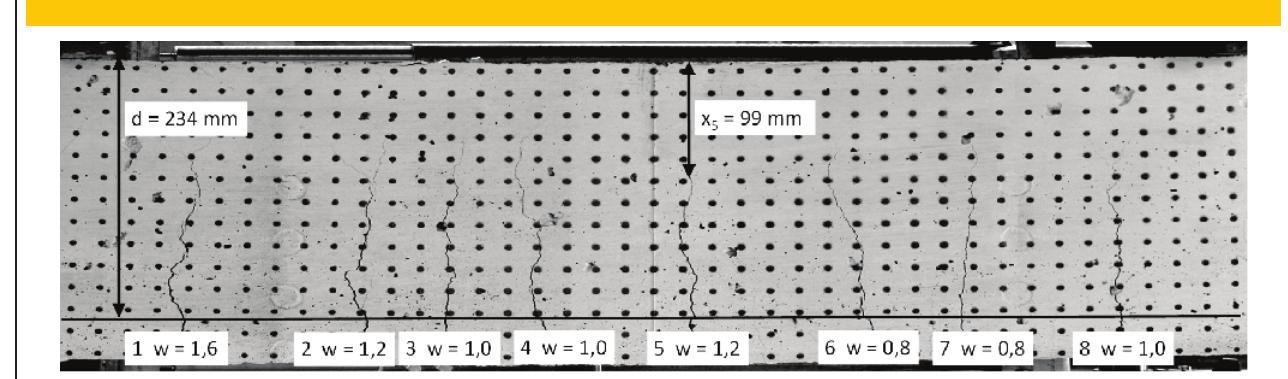
Figure 13 – Crack width and neutral axis depth in mm (stage